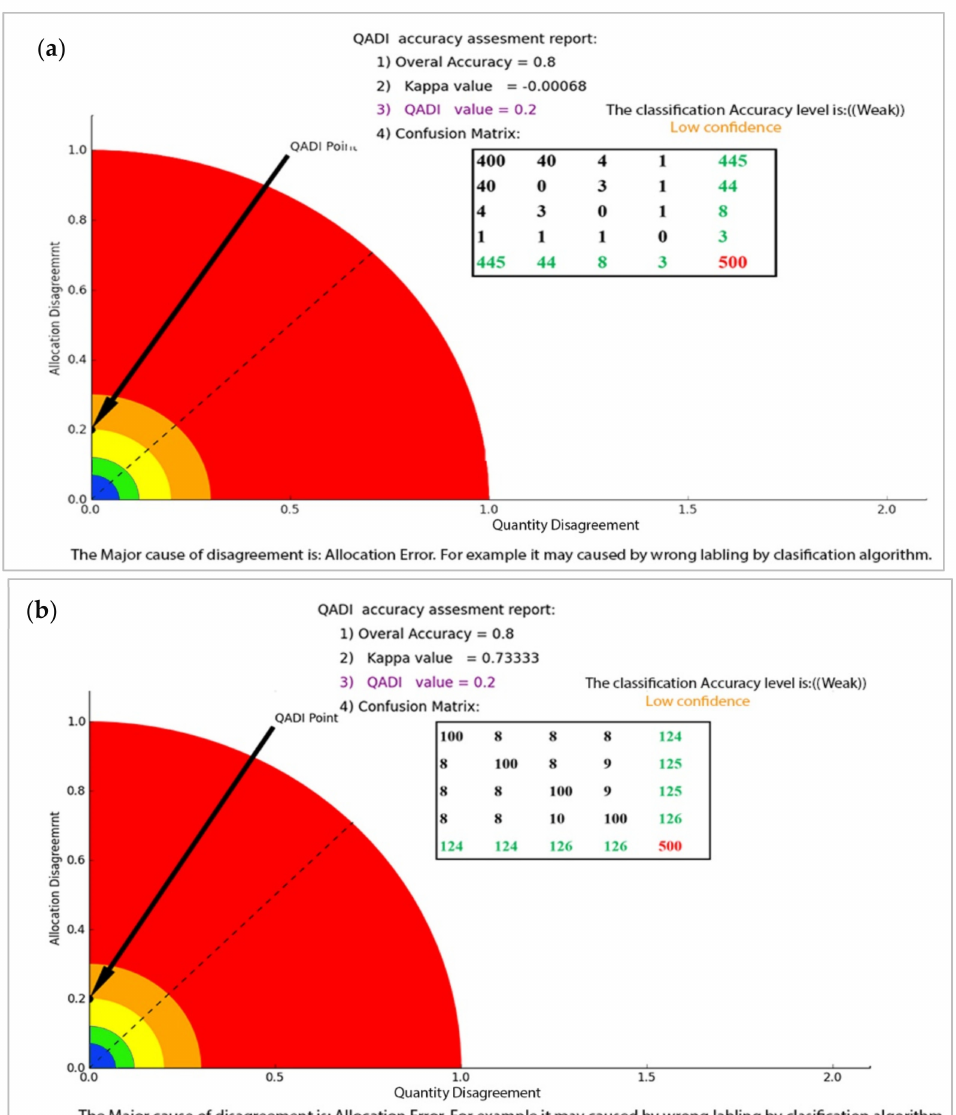
Figure 3. Accuracy assessment illustrated by the graphical representation of QADI. ( a ) QADI graph for Skewed matrix and ( b ) QADI graph for normal matrix2.7. Implementation and use